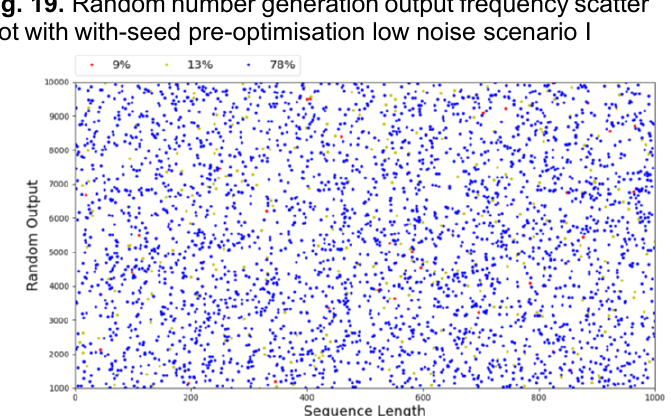
Fig. 20. Random number generation output frequency scatter plot with with-seed pre- optimisation low noise scenario II